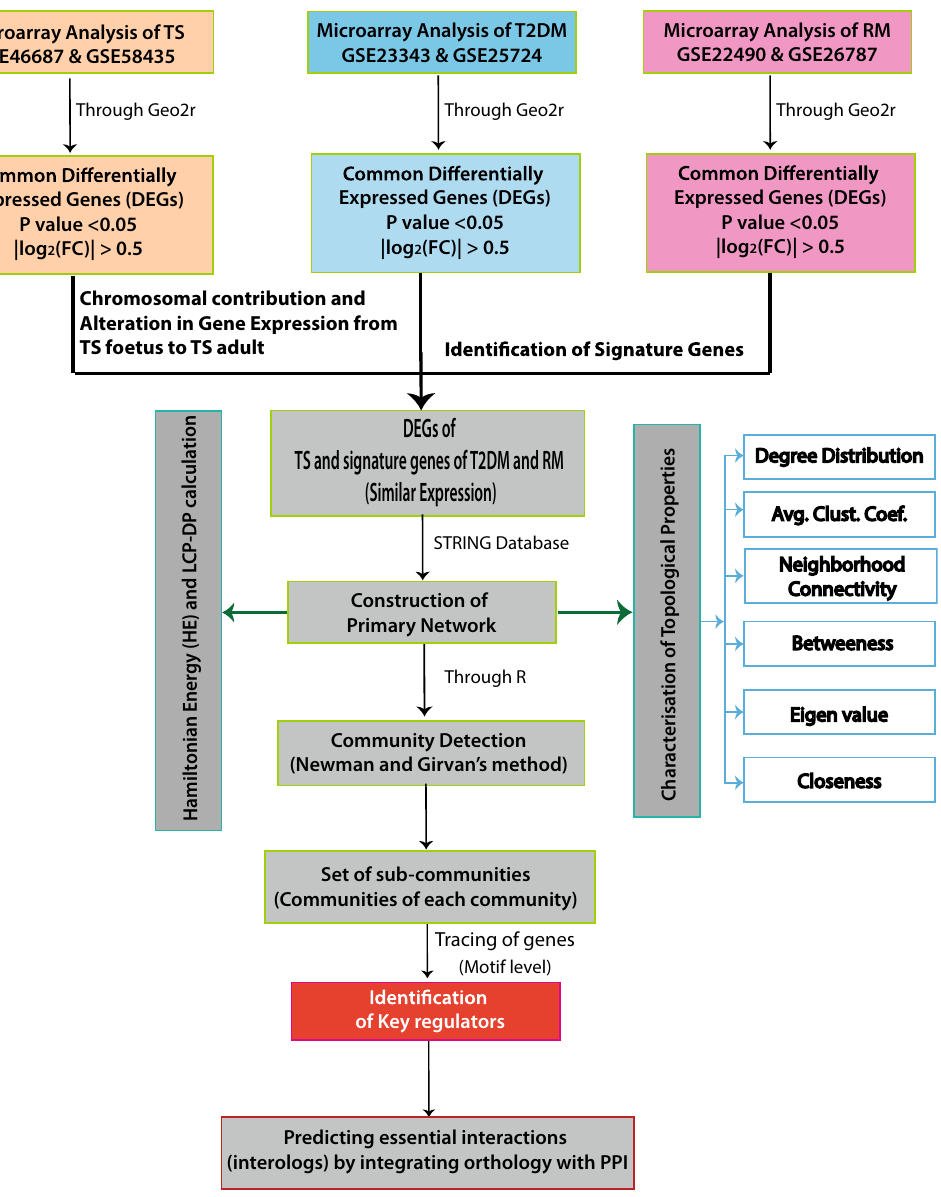
Figure 1. Illustration of the workflow of the integrative network-based approach of our study.